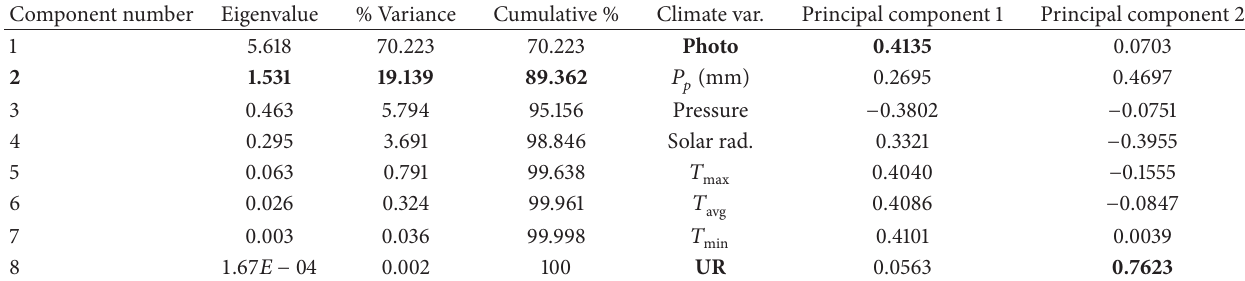
Table 2: Principal components analysis of Pinhais meteorological data for Araucaria angustifolia, for the fourth measurement year (July 2010 to August 2009).